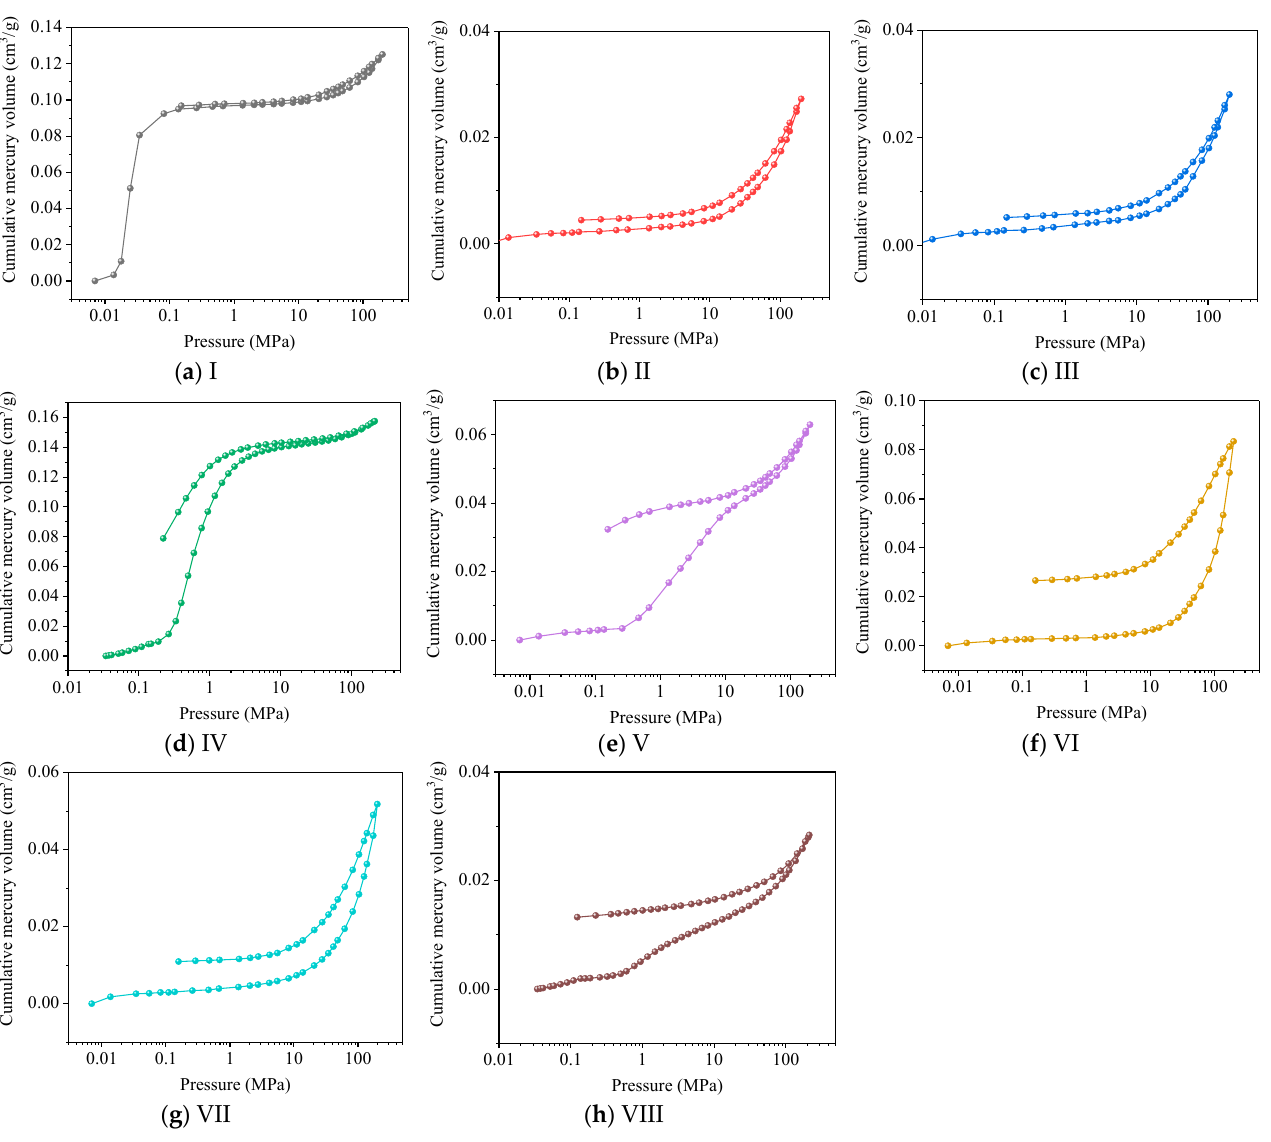
IV to 2.914 for sample I, D (cid:48) 2 from 2.008 sample IV to 2.984 for sample I, and D (cid:48)(cid:48) 2 from 2.000 sample IV to 2.890 for sample I. The pore structure of sample I is the most complicated, while the pore structure of sample IV is the least